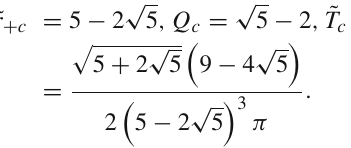
Fig. 2 Effective potentials for scalarized RN black holes with α = 5 for various values of q . They are all positive definite, which means that the scalarized solutions are stable against radial